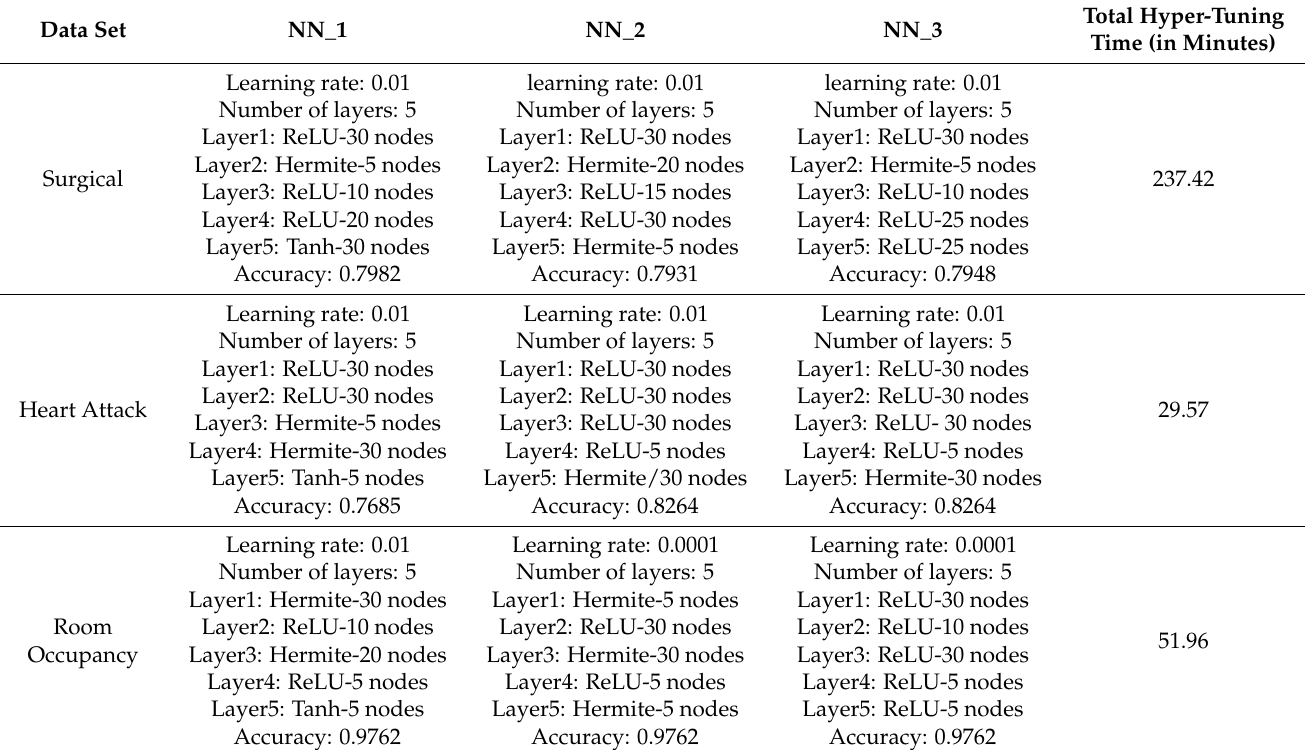
Table 6. (First Experiment) Optimal hyperparameter values, classification (i.e., validation) accuracy evaluated on the testing data, and total time needed to perform the hyperparameter optimization (i.e., total hyper-tuning time) obtained by the three best neural networks: NN_1, NN_2, and NN_3 (Data sets: surgical, heart attack, room occupancy, blood transfusion, banknote authentication, and